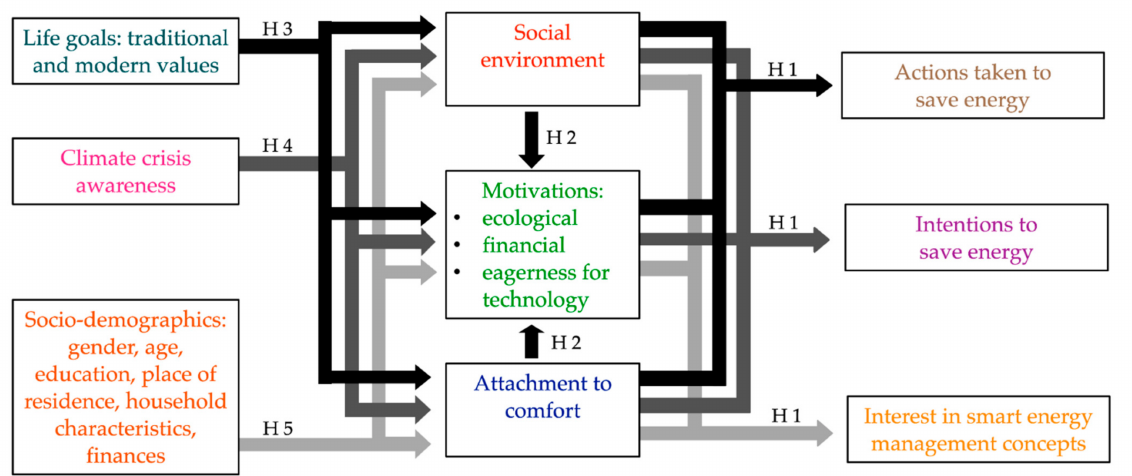
Figure 1. Determinants of energy-saving behaviors and